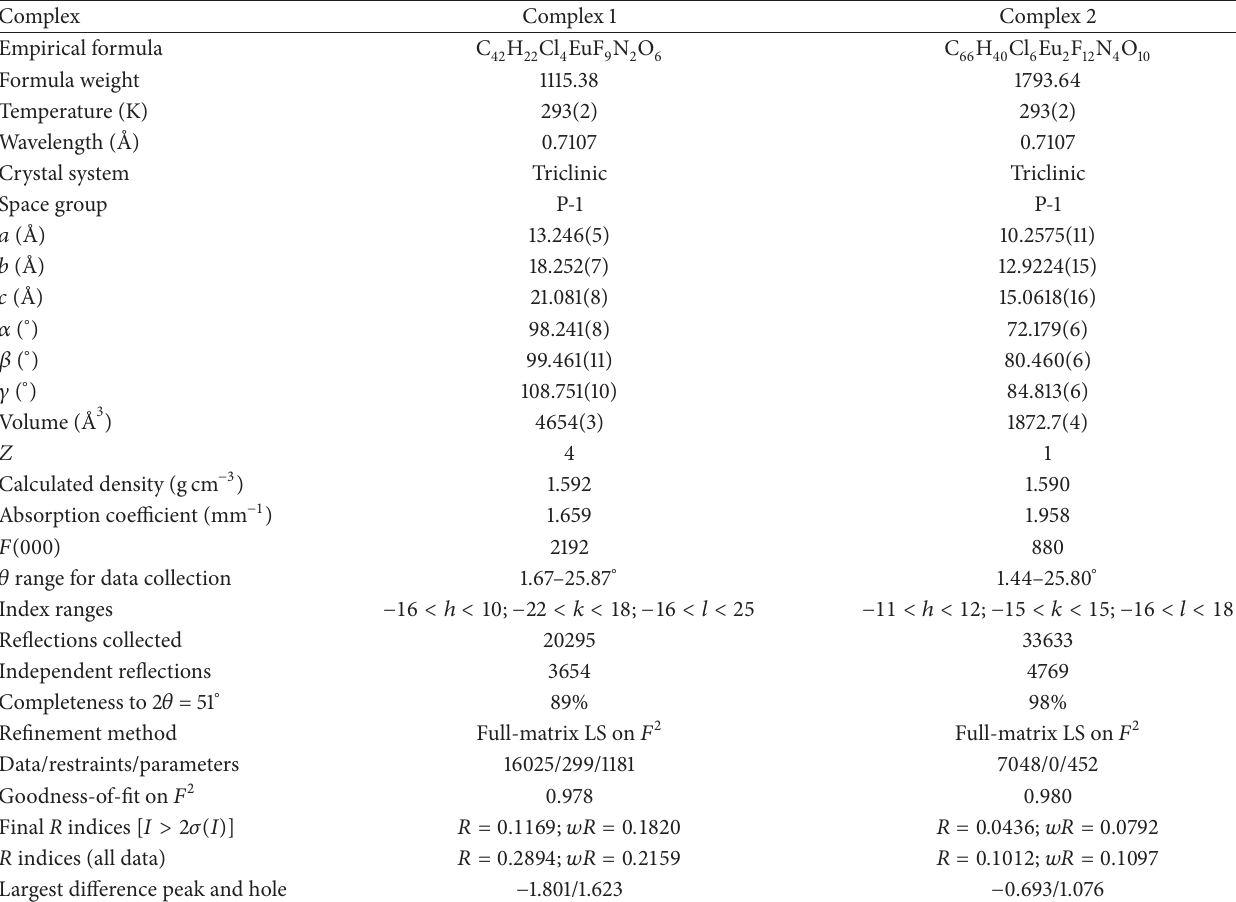
Table 1: Crystal data and structure refinement for the mononuclear and the homodinuclear Eu 3+ complexes.